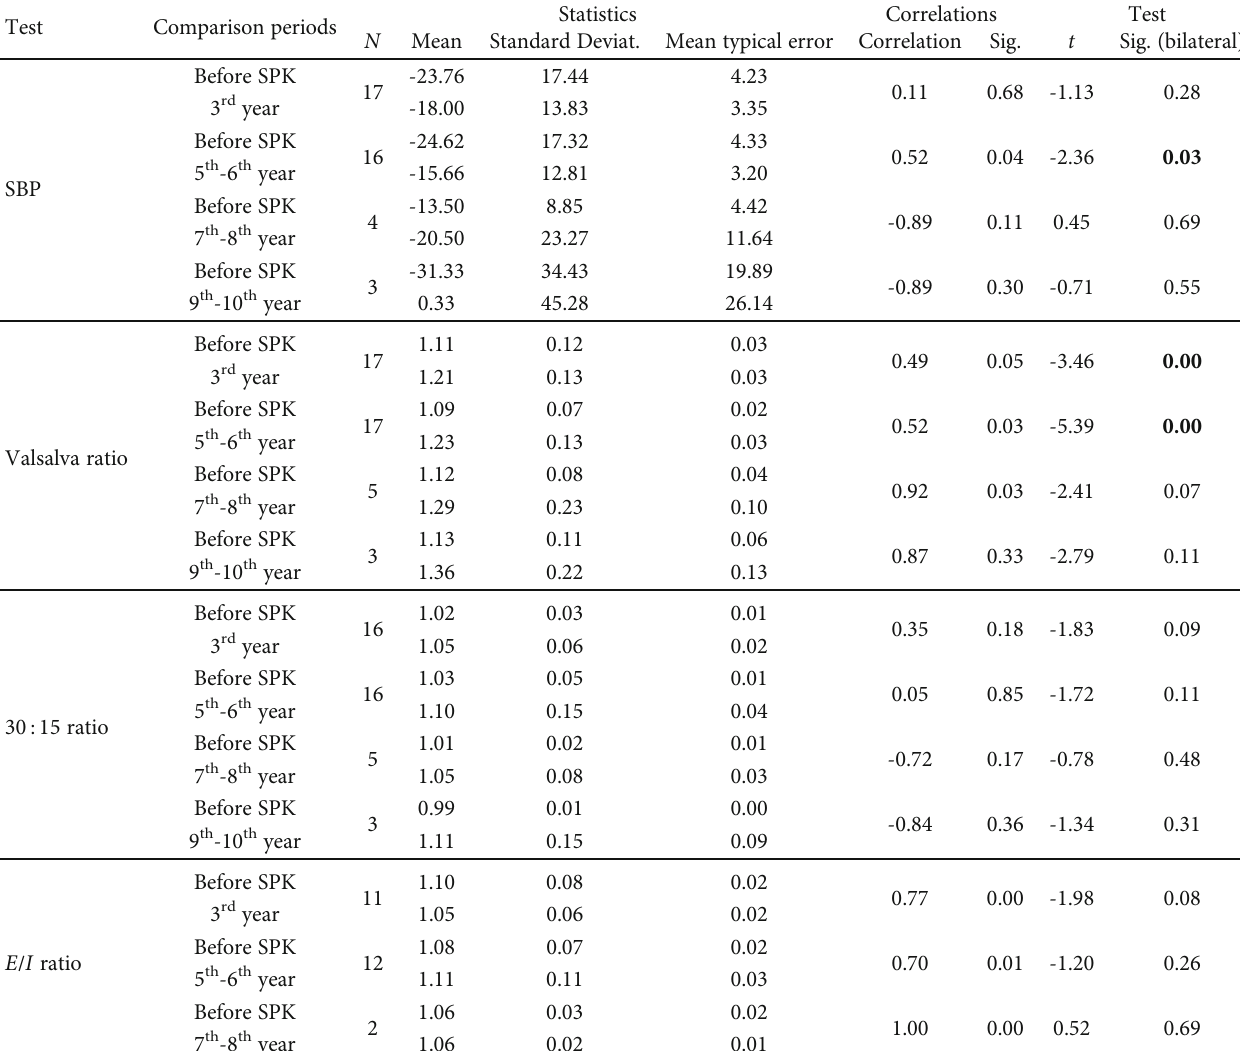
Table 2: Results of cardiovascular autonomic tests, comparing evolution before and after SPK transplantation in paired patient samples. Statistically results ( p < 0 : 05 ) are marked in